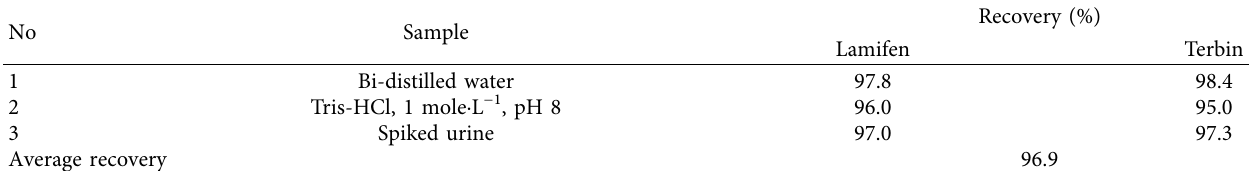
Table 4: Quantifcation of terbinafne in drug formulations and spiked urine (RSD, <